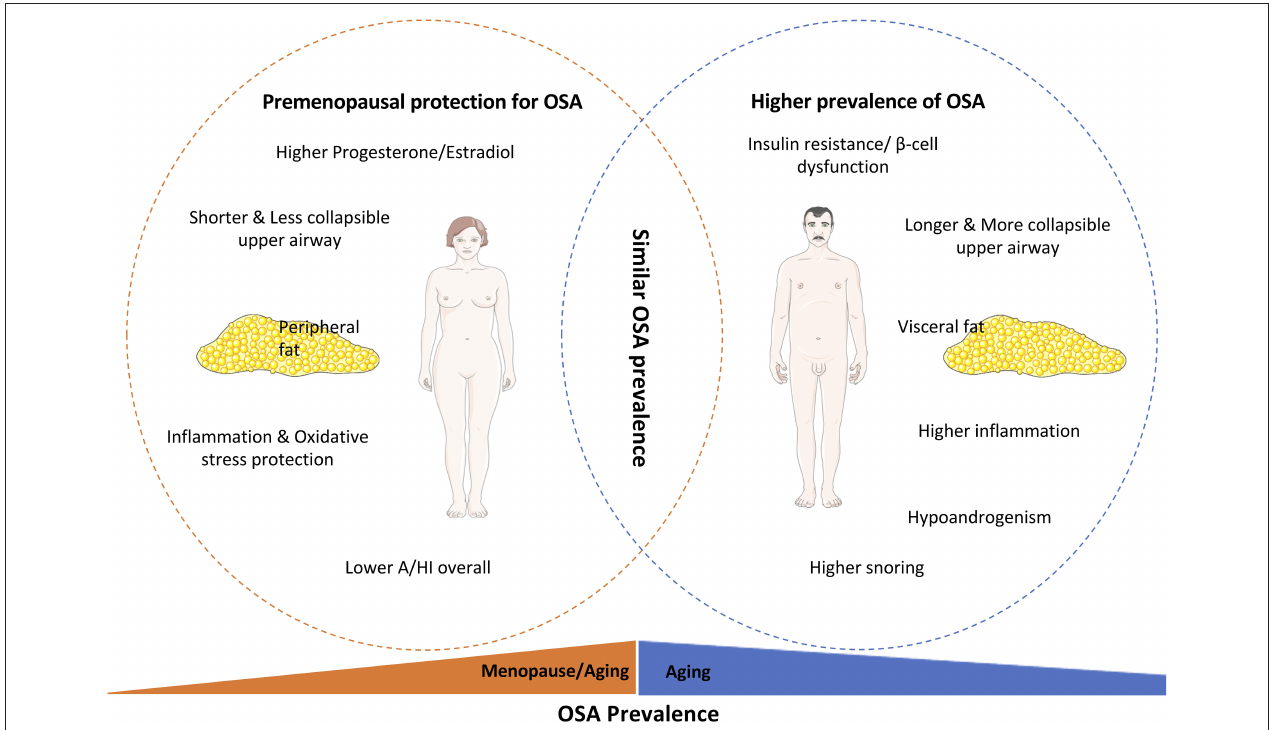
FIGURE 3 | Parameters involved in the gender-specific OSA prevalence and progression. It is quite accepted that OSA is highly prevalent in men compared to women, with the latter being protected from OSA-associated dysfunctions pre-menopause. This female protection is based on the upper airway mechanical differences, inflammatory and oxidative stress protection, and higher levels of sex hormones, such as estradiol and progesterone, in women. Furthermore, the higher prevalence of OSA in men is also associated with their higher susceptibility for insulin resistance and beta-cell dysfunction and the higher visceral deposition of fat in men instead of the higher subcutaneous deposition of adipose tissue in women. With aging the prevalence of OSA increases in both females and males, leading to a similar prevalence of OSA between the genders, mainly due to the loss of sexual hormones protection in women and the similar disruption on insulin secretion and